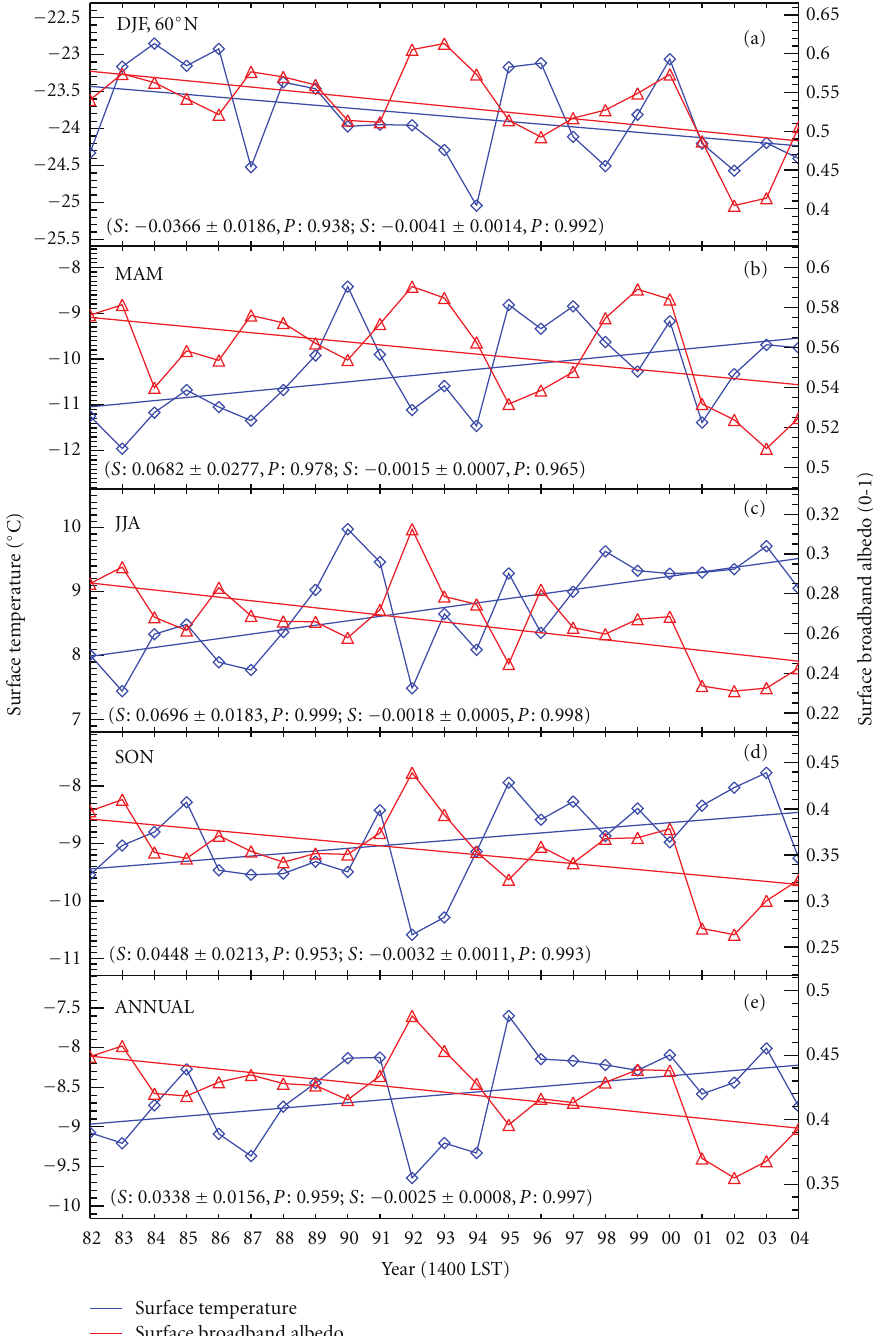
Figure 3: Time series and trends of surface skin temperature and broadband albedo in winter (DJF), spring (MAM), summer (JJA) and Autumn (SON) over the period of 1982 to 2004 for the Arctic region north of 60 ◦ N. Numbers in parentheses are the trend slope per year (“ S ”) with its standard deviation and the F test confidence level (“ P ”). The first pair of S and P denotes the surface temperature trend (blue) and the second pair is for the surface albedo